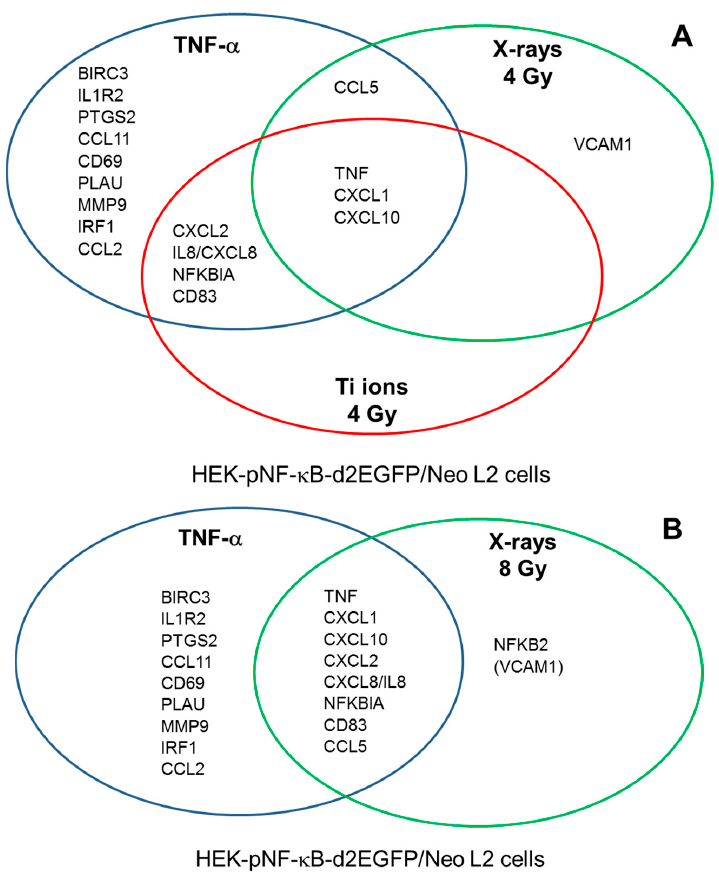
Figure 9. Diagram showing the expression of NF- κ B target genes by HEK cells 6 h after exposure to 10 ng/mL TNF- α , 4 Gy X-rays or 4 Gy Ti ions ( A ) and after exposure to 10 ng/mL TNF- α or 8 Gy X-rays ( B